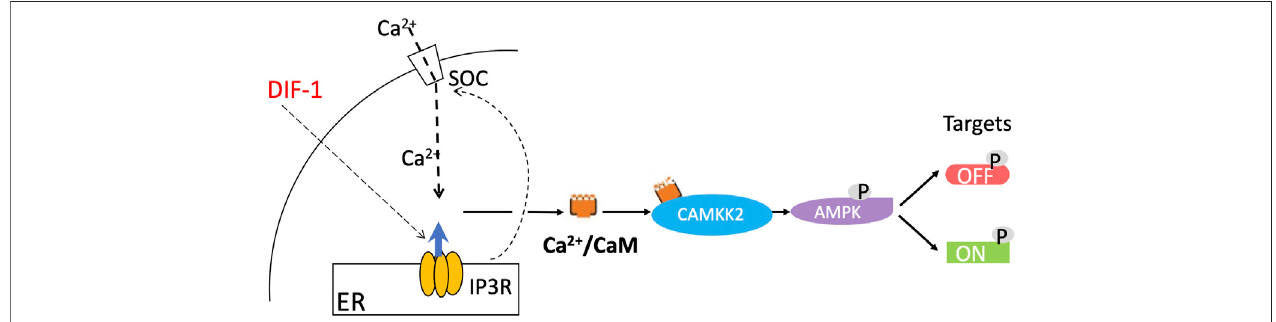
FIGURE 2 | Proposed pathway of stalk cell induction by DIF-1. DIF-1 triggers an increase in cytosolic Ca 2+ , a process dependent on IplA, a protein related to the mammalian IP 3 receptor, which triggers Ca 2+ release from the endoplasmic reticulum (Traynor and Kay, 2017) and may also induce Ca 2+ entry into the cell via a store- operated calcium channel. The concentration of Ca 2+ /calmodulin in turn increases, binding to and activating the calmodulin-dependent protein kinase CaMKK2. This then phosphorylatesand activates AMPK, which phosphorylates various target proteins, activating some(includingcalcineurinand inhibiting others(Sugdenet al., 2015) and initiating the prestalk/stalk (ST)